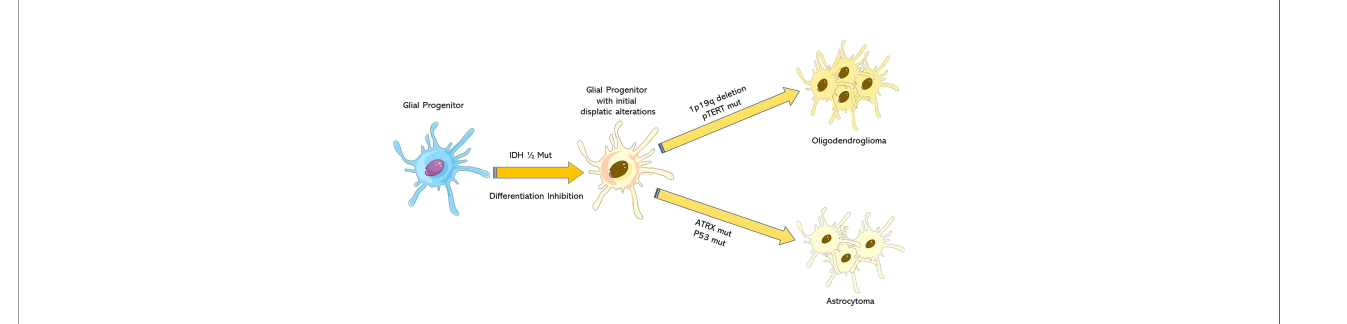
FIGURE 2 | WHOCNS2016 algorithm for diffuse low-grade glioma (DLGG) diagnosis. A scheme of molecular analysis is needed to formulate a precise diagnosis of DLGG, according to WHOCNS2016.